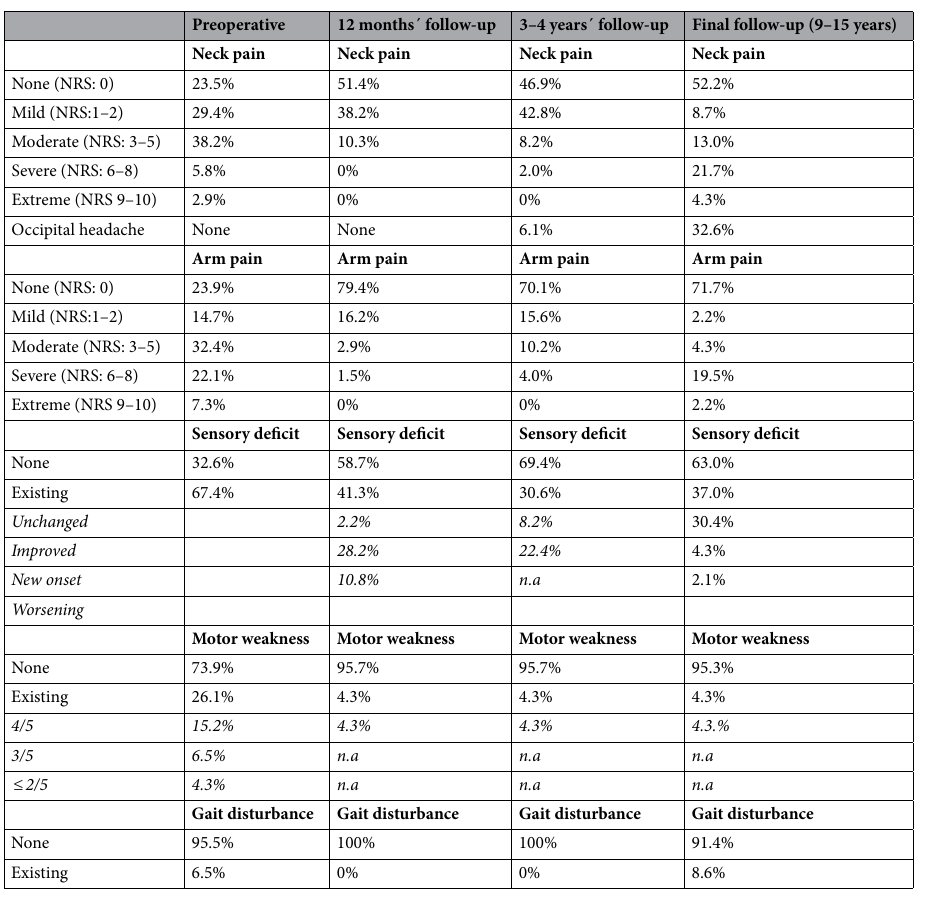
Table 3. Compilation of clinical outcome.